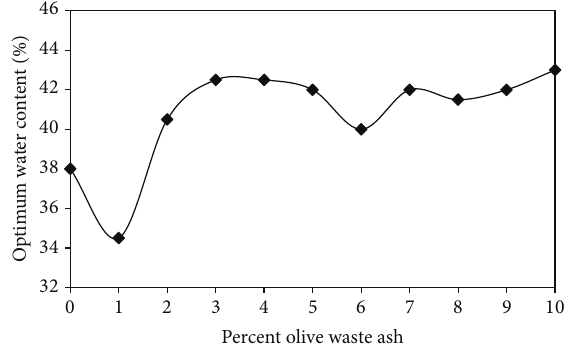
Figure 5: Effect of olive waste ash on the optimum water content.